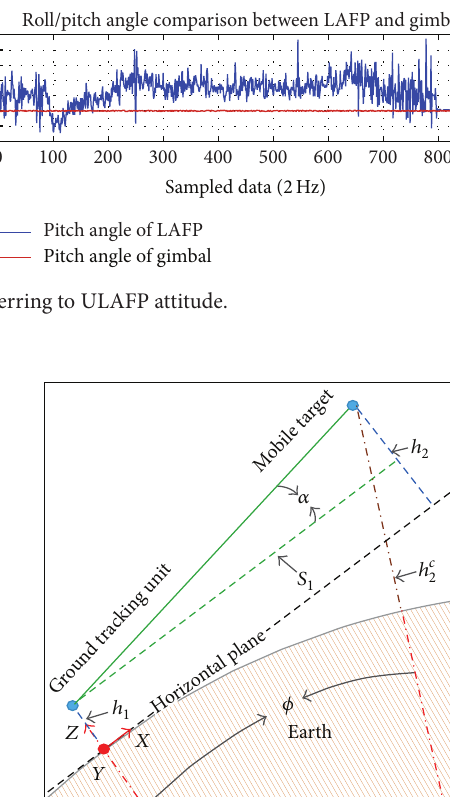
Figure 5: Block diagram of ground antenna tracking unit.